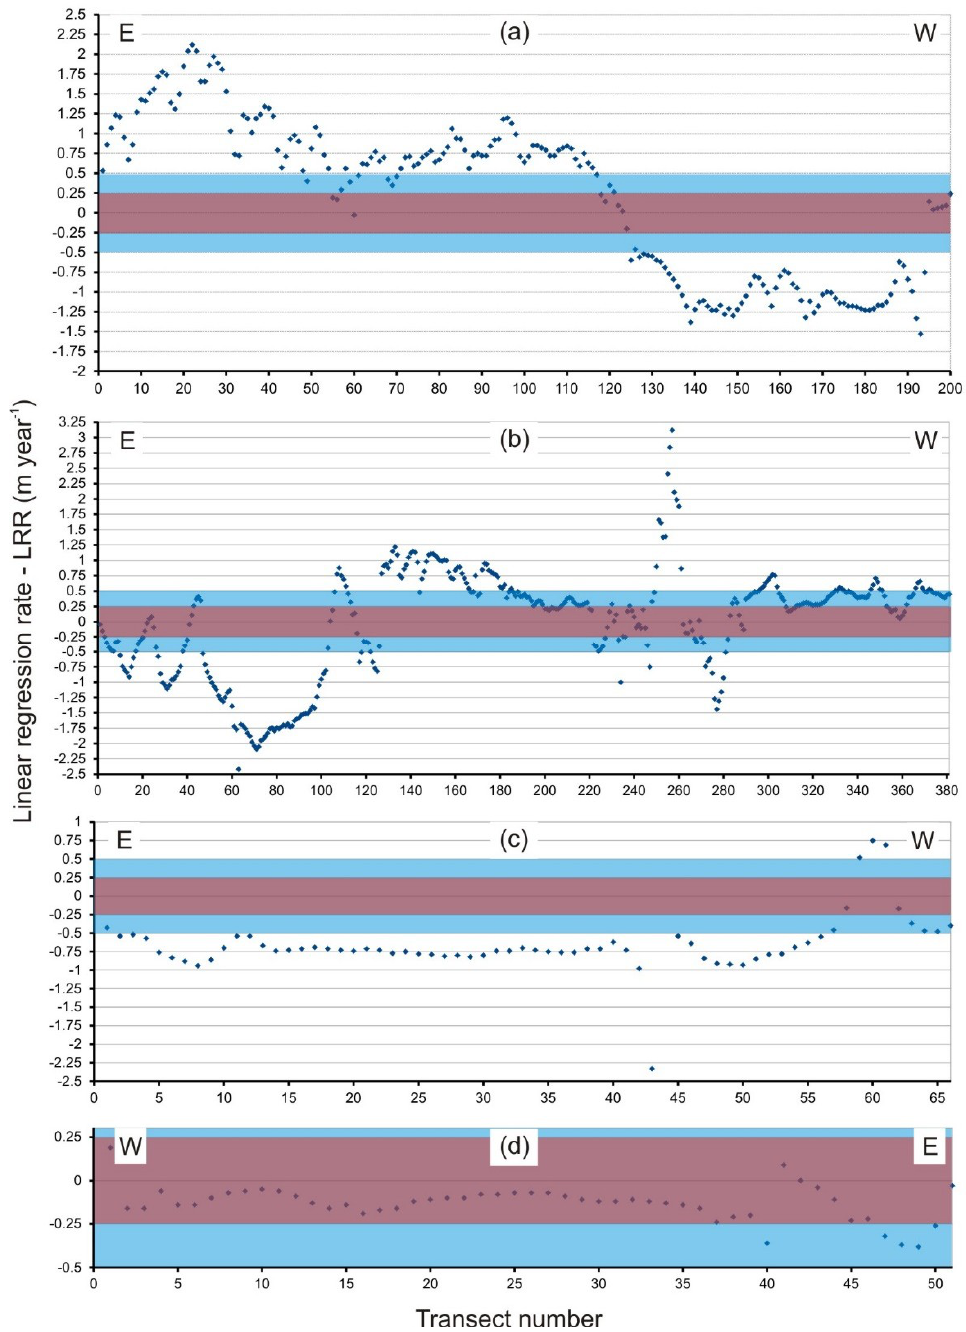
Figure 7. Differences in dune historical trends using two different “relative stability” class limits: ±0.5 m year −1 (blue area) and ±0.25 m year −1 (red area) for the four dune systems analyzed, Laredo ( a ), Somo-Loredo ( b ), Liencres ( c ), and Oyambre ( d ).